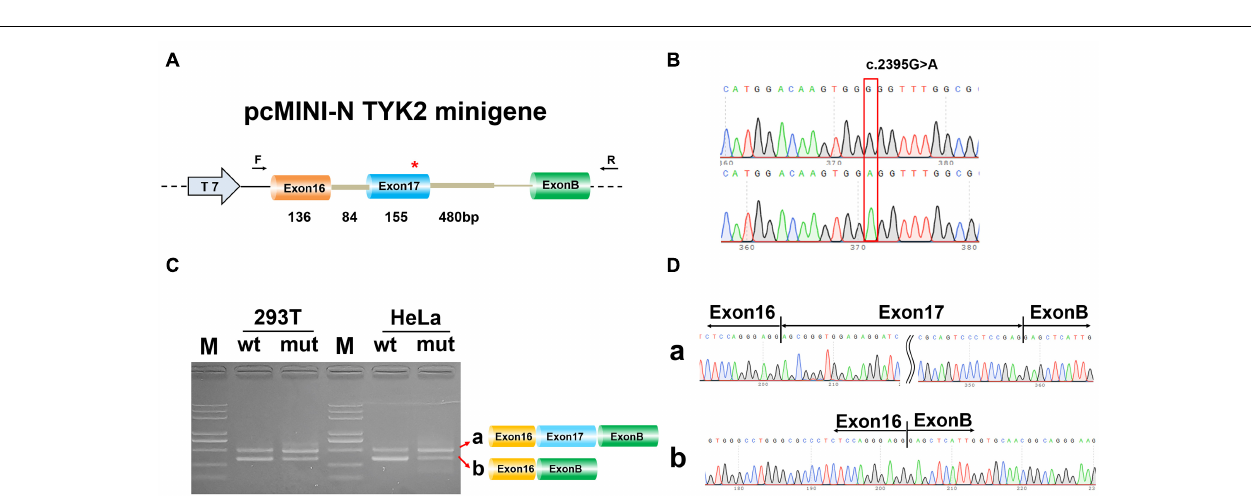
FIGURE 4 | Minigene analysis based on pcMINI-N-TYK2-wt/mut recombinant vector. (A) Schematic illustration of cloned vectors. (B) Sanger sequencing results of the recombinant vector. (C) Electrophoresis results of transcript PCR products in both 293T and HeLa cell lines. (D) Sanger sequencing of PCR products. Red *indicates the mutation site.